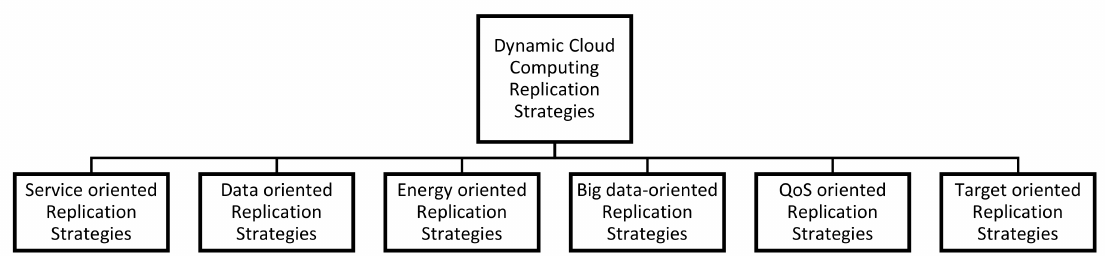
Figure 3. Demonstrates the classification of dynamic cloud computing replication strategies based on services and